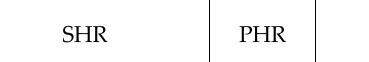
Algorithm 1 : Pseudo code for the congestion condition transmission algorithm